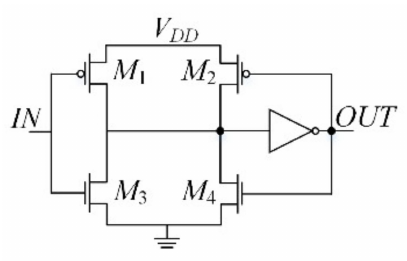
Figure 4. Schematic of the Schmitt